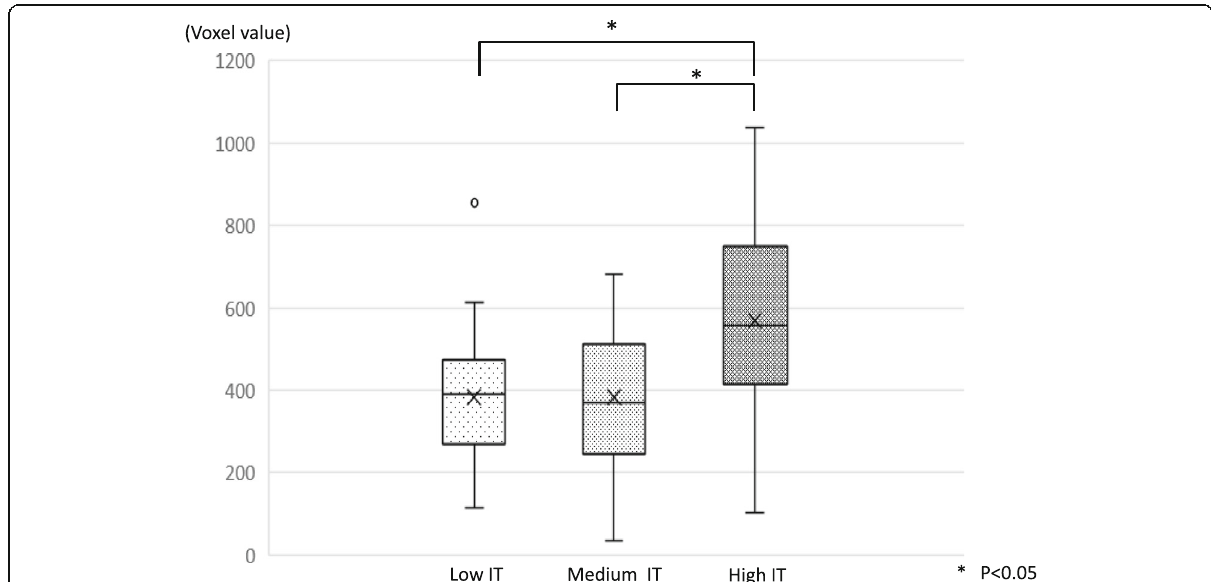
Fig. 8 The relationship between average voxel value and insertion torque (averaged over the entire treatment area). The comparison of average voxel value among IT groups. Average voxel value was 384.0 ± 154.6 in the low IT group, 387.7 ± 147.7 in the medium IT group, and 619.2 ± 200.4